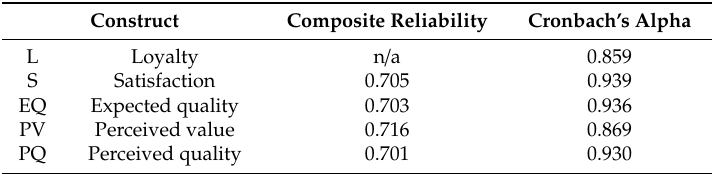
Table 6. Composite Reliability and Cronbach’s Alpha.